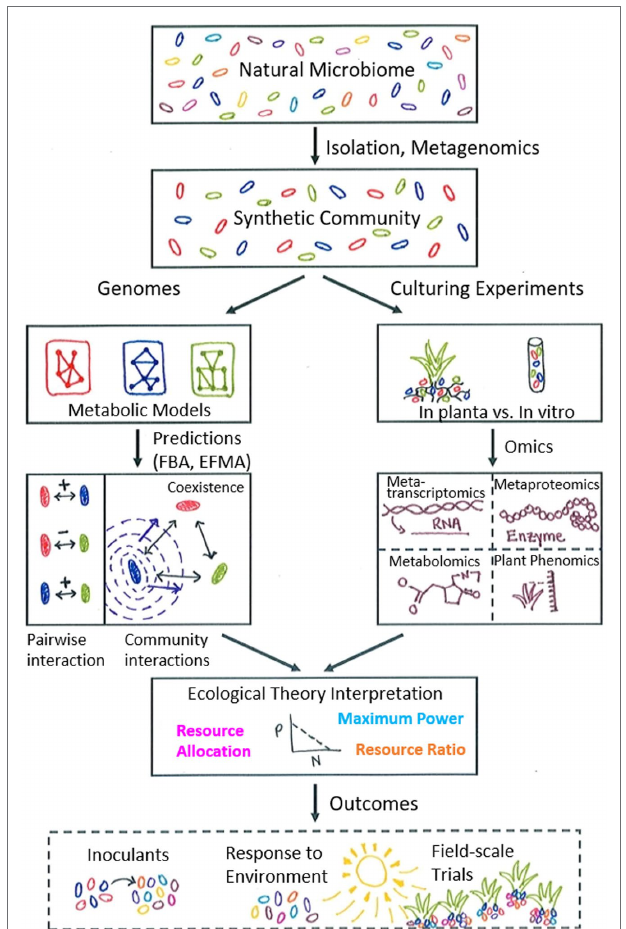
FIGURE 1 | Schematic illustrating proposed metabolic modelling workflow with synthetic communities as input. The natural microbiome is a complex environment and is simplified to a synthetic community with a tractable number of microorganisms via experimental isolation techniques and/or metagenomics methods. Genomes for this limited number of microorganisms are used to construct metabolic models for each species, which can then be used with pathway simulation tools (flux balance analysis, FBA; elementary flux mode analysis, EFMA) to predict both pairwise and community interactions to observe changes due to additional community members and determine patterns of interaction. In the example shown, the blue microbe secretes a compound that is beneficial to both the red and green microbes and stabilizes their original negative pairwise interaction. Complementarily, culturing experiments can be used to examine the responses of microbial communities (both in planta and in vitro ) to environmental variables such as limited nutrients or water stress. Collecting molecular data under specific experimental conditions provides data to integrate with modelling predictions, which can be interpreted with the aid of relevant ecological theory, such as resource ratio theory, resource allocation theory, or the maximum power principle. This process leads to iterative refinement of both models and experimental design, ultimately contributing to broader outcomes relevant to agricultural practice, such as the design of microbial inoculants to promote plant growth and resilience, an improved understanding of plant-microbe response to the environment under changing climate conditions, and the implementation of field-scale trials to further test interaction principles in the natural